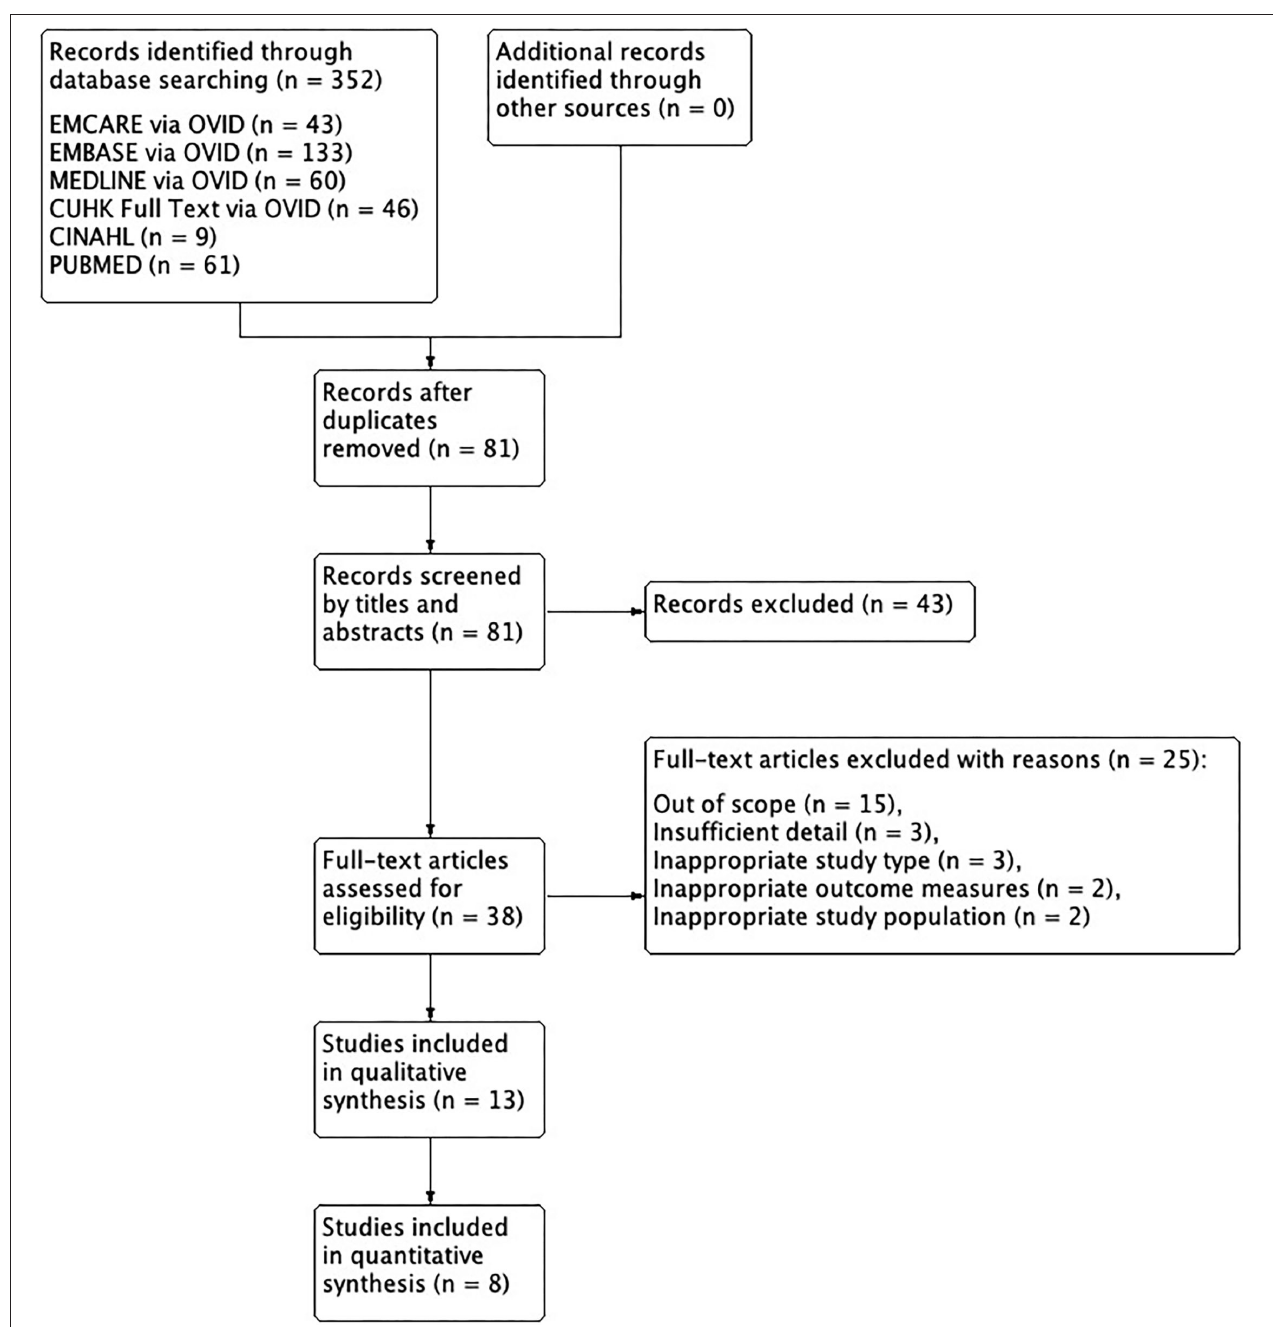
FIGURE 1 | PRISMA flow diagram on